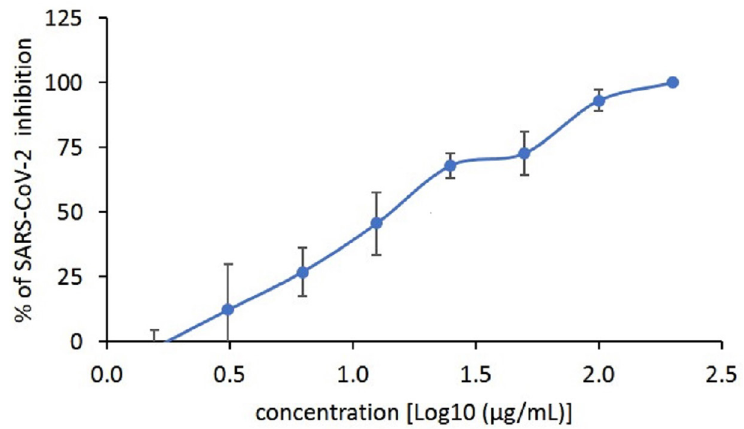
Figure 2. ( A) Focus reduction neutralization assay using SARS-CoV-2 Wuhan-Hu-1 assessing a range of concentrations of G921 from 1.6 to 200 µg/mL with positive and negative controls. (B) Plot of G921 percent inhibition of SARS-CoV-2 foci in a dose-dependent